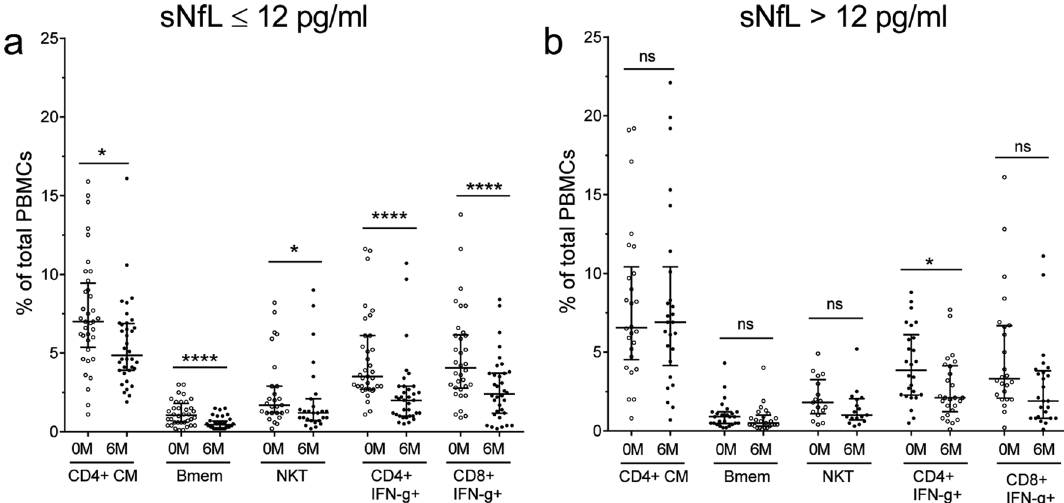
Figure 4. Blood cell subsets changes after 6 months of dimethyl fumarate (DMF) treatment depend on basal serum neurofilament light chain (sNfL) values. Percentages of blood Central Memory (CM) CD4+ T lymphocytes, memory B (Bmem) cells, Natural Killer T (NKT) cells, and CD4+ and CD8+ T lymphocytes producing Interferon-gamma (IFN-g) at baseline (0 M) and after six months (6 M) of dimethyl fumarate treatment in 62 relapsing–remitting multiple sclerosis patients showing baseline sNfL values ≤ 12 (n = 36, a ) or > 12 (n = 26, b ) pg/ml. Percentages are referred to total peripheral blood mononuclear cells (PBMCs). Medians and Interquartile Ranges are shown. ns: not significant. p values are corrected by Bonferroni test. * p < 0.05; ** p < 0.01; **** p <